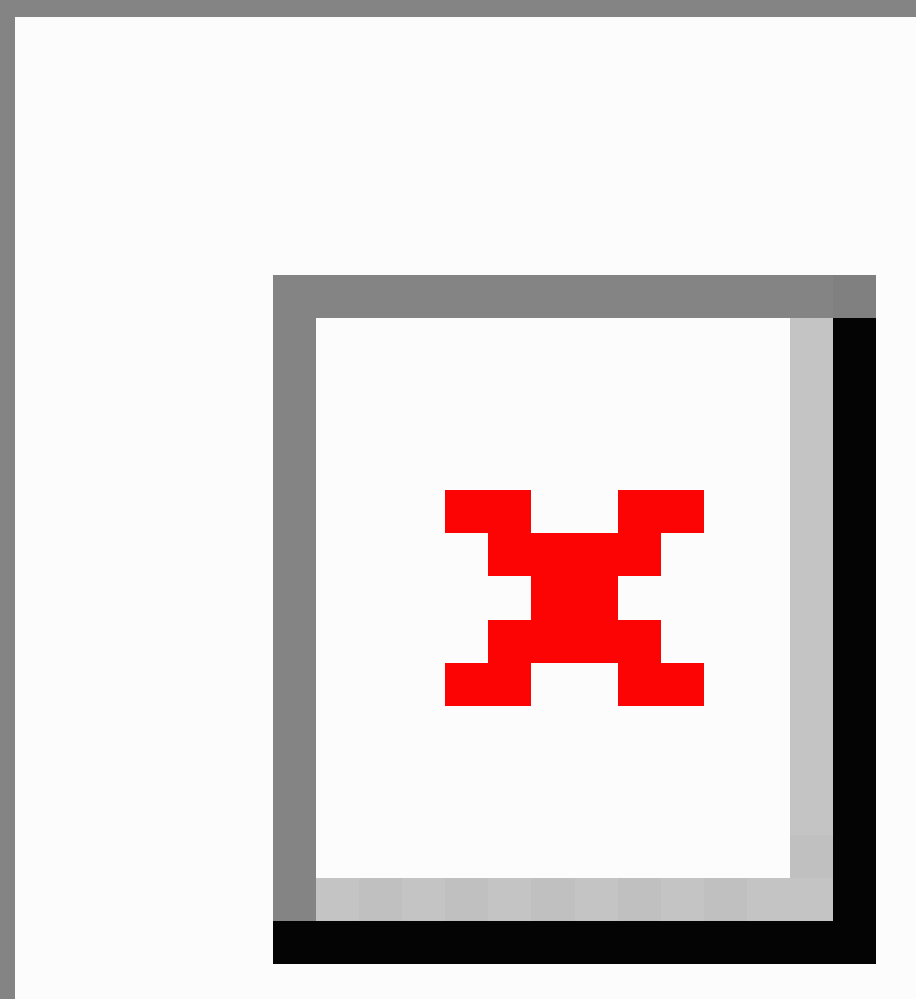
Figure 2. Screenshot of e-couch interpersonal psychotherapy (IPT)